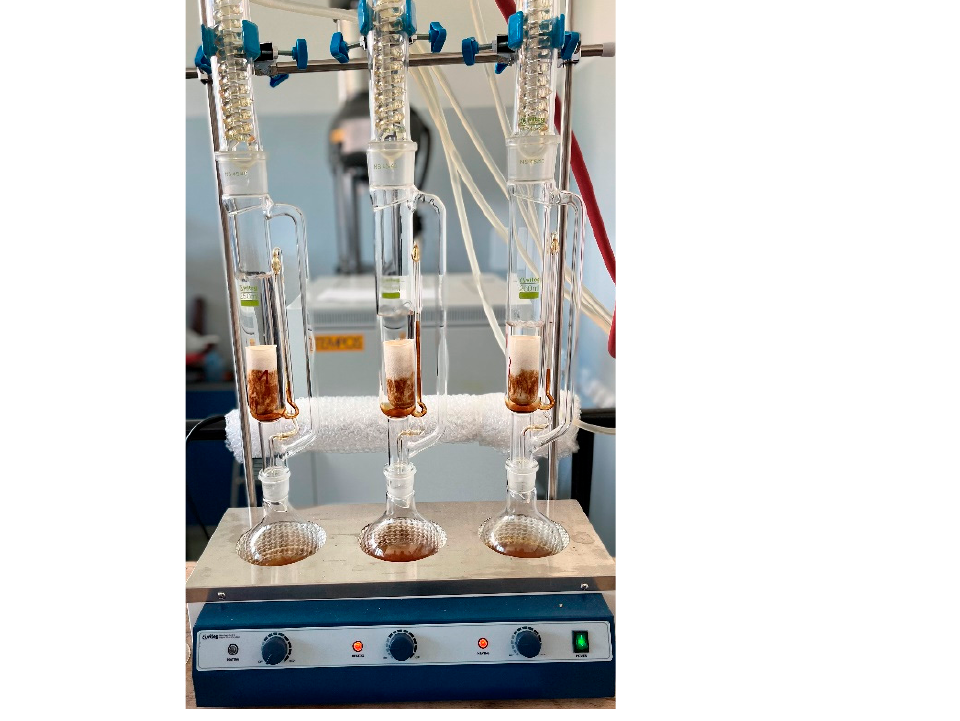
Table 1. Marking and characteristics of fillers (adhesive bonds).